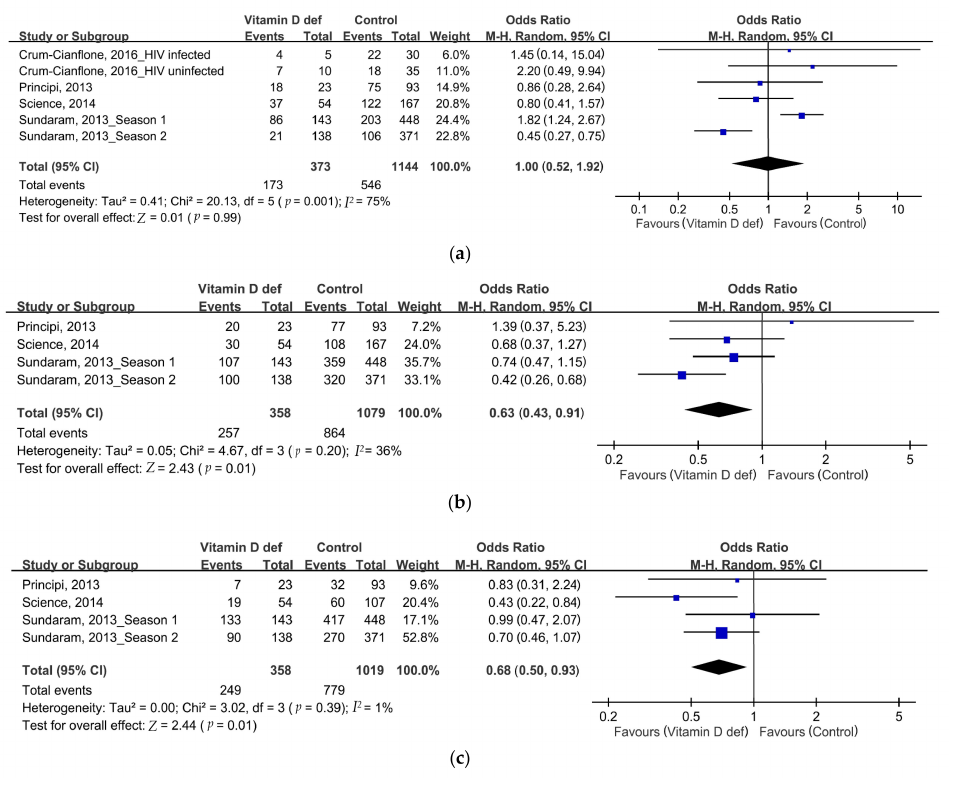
Figure 2. Forrest plot of the SP rates of influenza vaccination in the VDD (vitamin D deficiency) and placebo groups. ( a ) Strain A/H1N1; ( b ) strain A/H3N2; ( c ) strain B. df = degrees of freedom; def = deficiency; M-H =